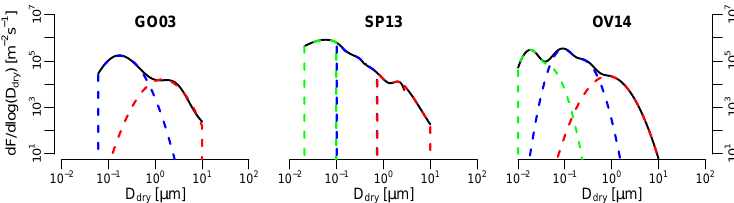
Figure 3. Modal splitting of the sea salt emission parameterizations GO03 (left), SP13 (center), and OV14 (right). The color indicates the size mode in which the sea salt is emitted: green corresponds to the Aitken mode, blue to the accumulation mode and red to the coarse mode.